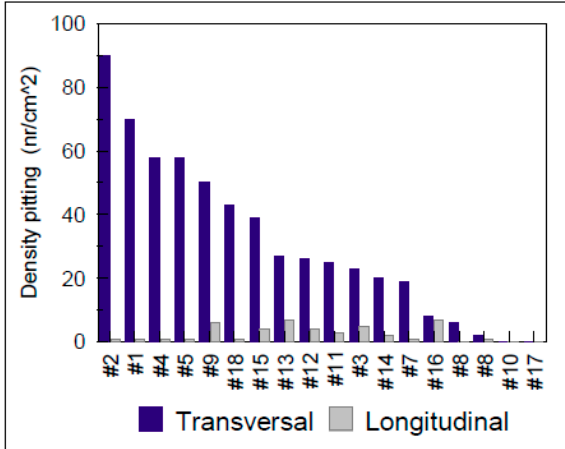
Figure 6. Pitting test results of the transverse and longitudinal surfaces for various grades of steel alloys (0.5 M FeCl 3 test medium at 50° for 2 h).